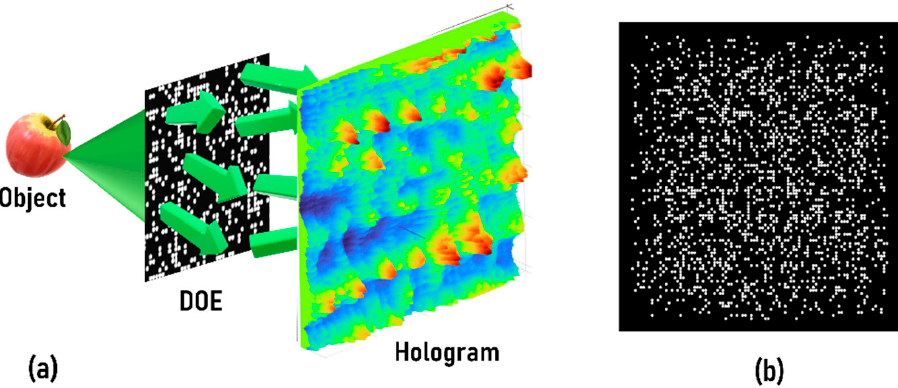
Figure 7. ( a ) Optical configuration of CAI with a pinhole array mask. ( b ) Image of the pinhole array mask.